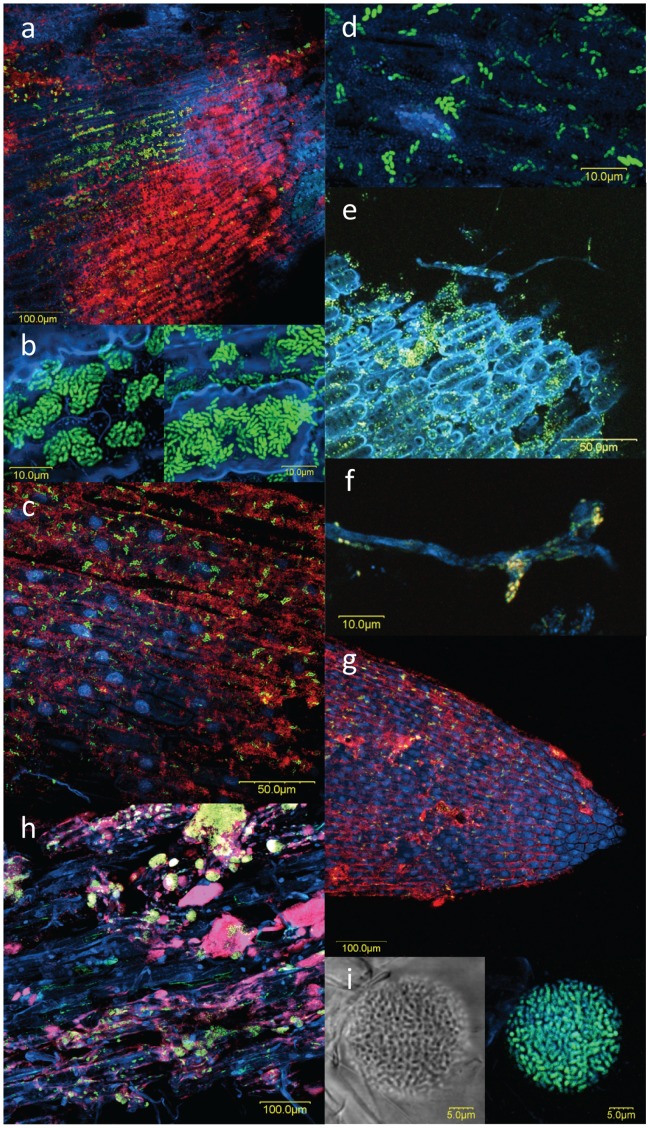
Cucumber seed and root colonization by Massilia.FISH-CLSM analyses of the plant samples: blue- DAPI stain; red- total bacteria; green- Massilia. a,b) Seed radicle after 24 h in compost-amended perlite; c,d) seed coat after 24 h in compost-amended perlite; e,f) seed coat after 24 h in Pythium aphanidermatum-inoculated perlite; g) root tip after 48 h in perlite; h) mature zone of primary root after 48 h in perlite; colony on root after 48 h in perlite: bright-field image on the right, Massilia probe and DAPI stain on the left. Arrows indicate Pythium hyphae.